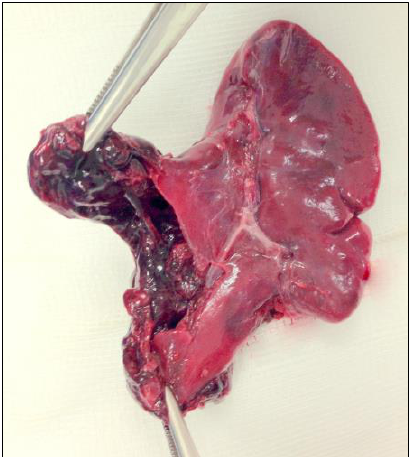
Figure 1: Resected spleen, showing a distorted anatomy and a ruptured lower pole. Patient slowly recovered from shock and its clinical derangements, and was discharged uneventfully after days. Penicillin was started and immunization against encapsulated agents was given at age 2 months. Histopathology analysis reported a ruptured cavernous hemangioma of the spleen (Fig.